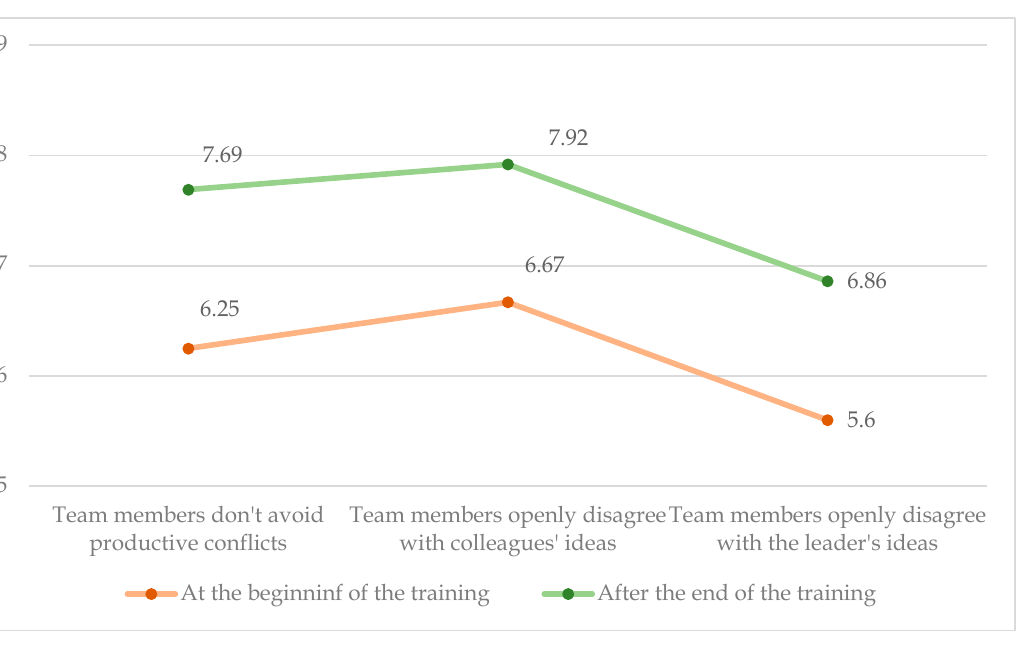
Figure 6. Results of answers to the block of questions “Building trust” (in comparison of answers to questions at the beginning and after the end of the training).